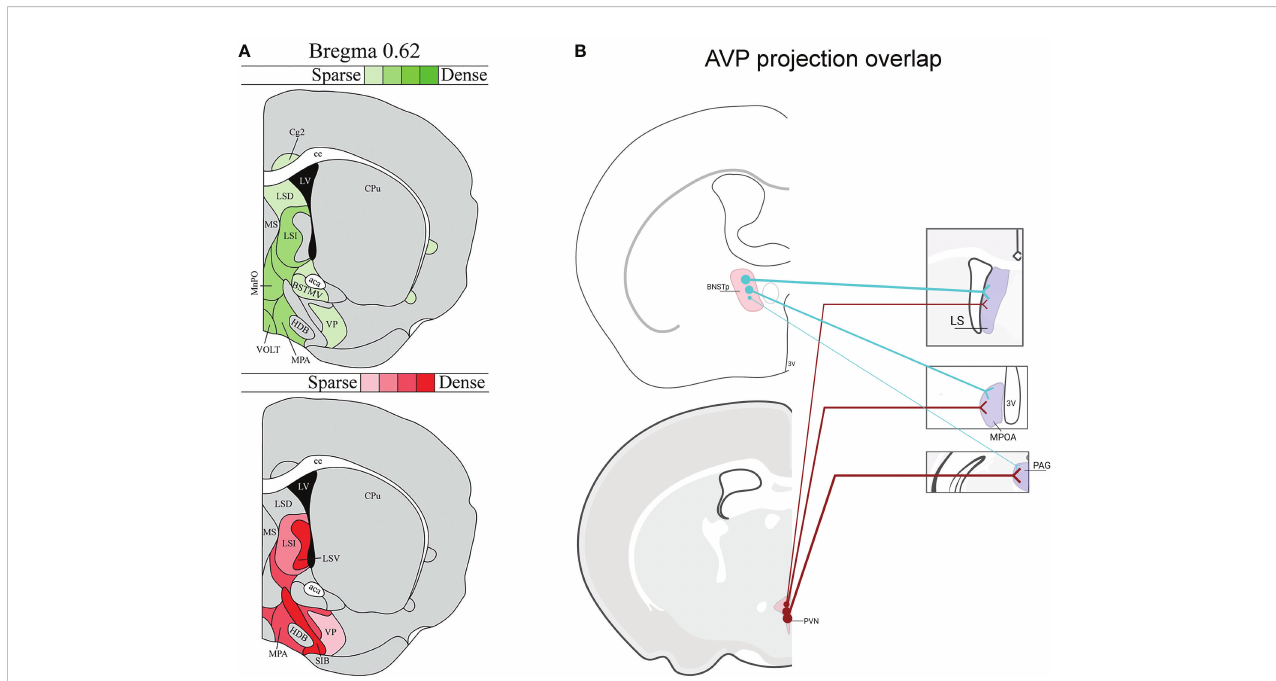
FIGURE 1 Vasopressin (AVP) projection site overlap in mice . (A) Image modi fi ed from (46) demonstrating that the LS and ventral forebrain receives steroid- dependent AVP signal likely from BNST/MeA as well as from the hypothalamus. Red shading indicates location of AVP-ir fi bers that decrease after gonadectomy in males. Green shading indicates location of AVP-ir fi bers likely originating from PVN, SON, or accessory cells (i.e., AVP-ir remained after gonadectomy and SCN lesions). AVP-ir fi ber density is indicated by color shade. (B) Examples of several regions from (46) that receive both BNST and PVN AVP input: lateral septum (LS), medial preoptic area (MPOA), periaqueductal gray (PAG) (not all overlap regions are listed). Thickness of lines represents the strength of AVP fi ber projections. Created with